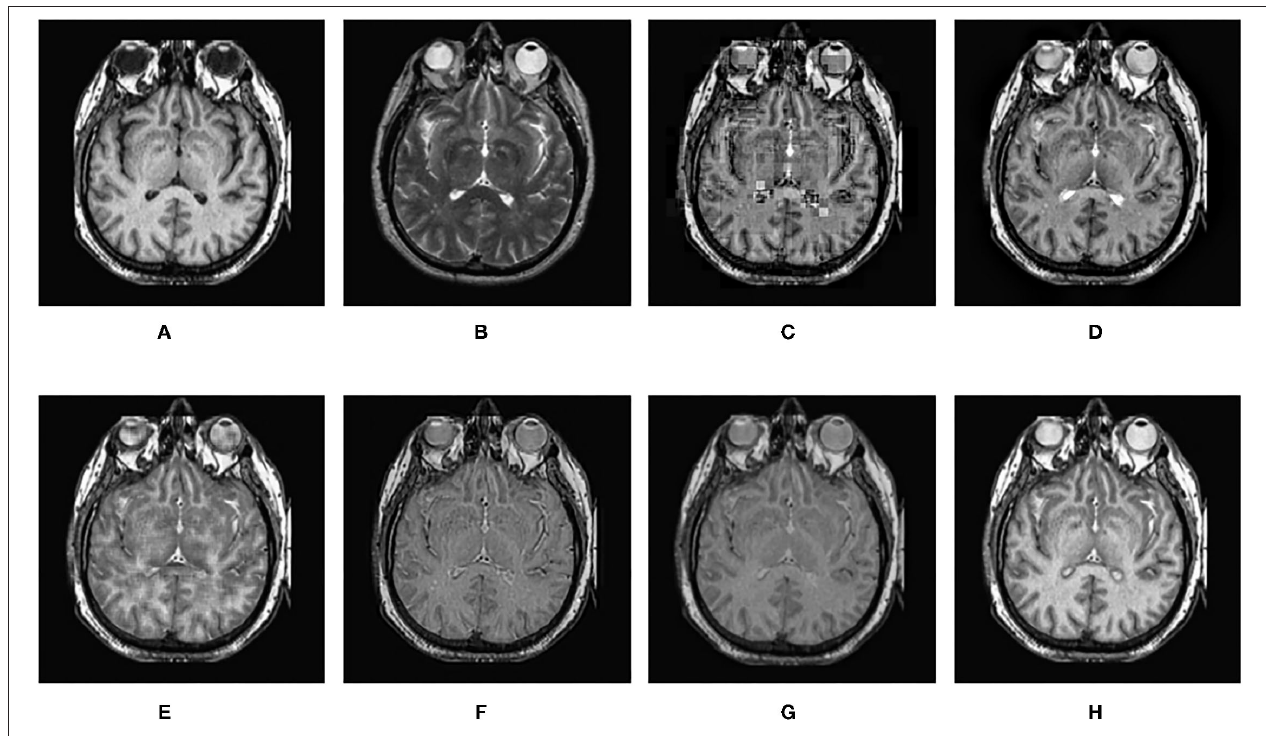
FIGURE 15 | Comparison experimental results of CT and MRI images. (A) original image (CT); (B) original image (MRI); (C) DWT; (D) LP; (E) SR; (F) DTCWT-SR; (G) VGG; (H) MPS.